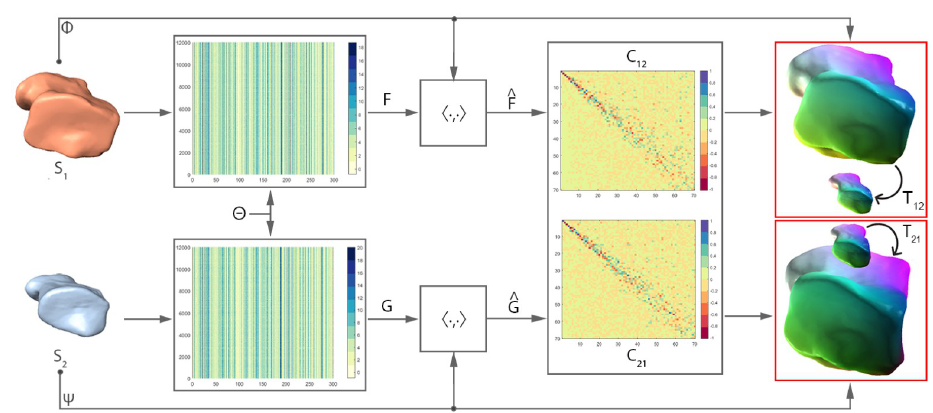
Fig 2. Deep Functional Maps network architecture demonstrating functional and soft P2P map estimation in both directions. We start with an initial pair of source and target shapes S 1 and S 2 , respectively. Θ is a Siamese harmonic surface network, and F and C are the truncated Laplacian eigenbases for S 1 and S 2 . Learned spatial descriptors are then projected to their corresponding bases to form F and G . C 12 and C 21 are 70x70 functional maps (FMs) estimated in the forward and backward directions between source and target. On the far right are the recovered P2P maps T 12 and T 21 , respectively. In P2P maps, visual representation of correspondence is demonstrated between (homologous) features that have the same color.